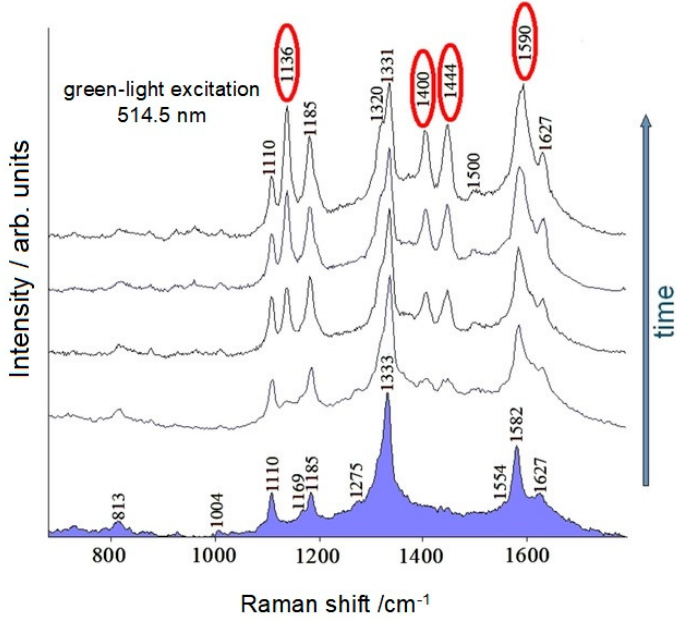
Figure 12. SERS spectra of DANS in Ag colloid, recorded every two minutes. This plasmon-induced reaction could be considered due to the catalyzing effect of the nanostructured surface of the colloidal silver particles. The DFT approach was